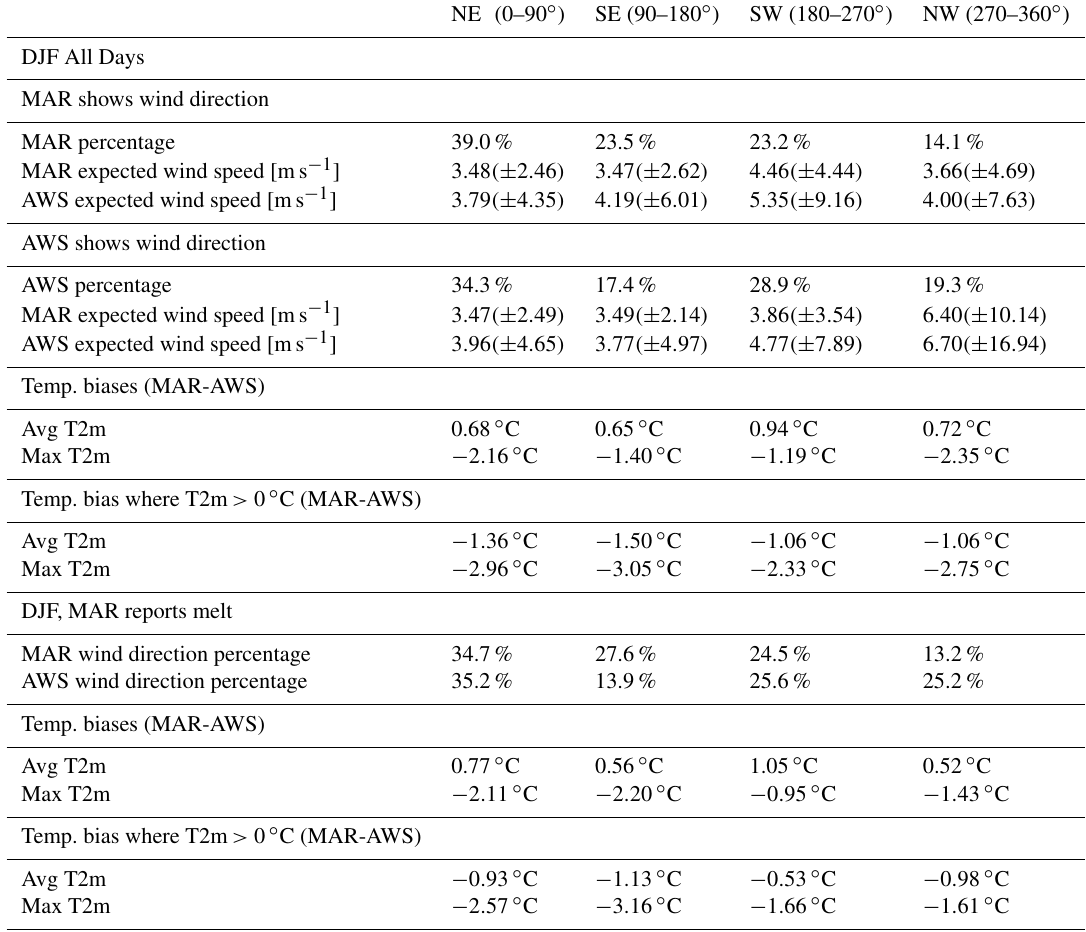
Table 2. Proportions for wind direction and associated temperature biases at the Larsen Ice Shelf AWS station from 2000–2009 restricted to the summer season